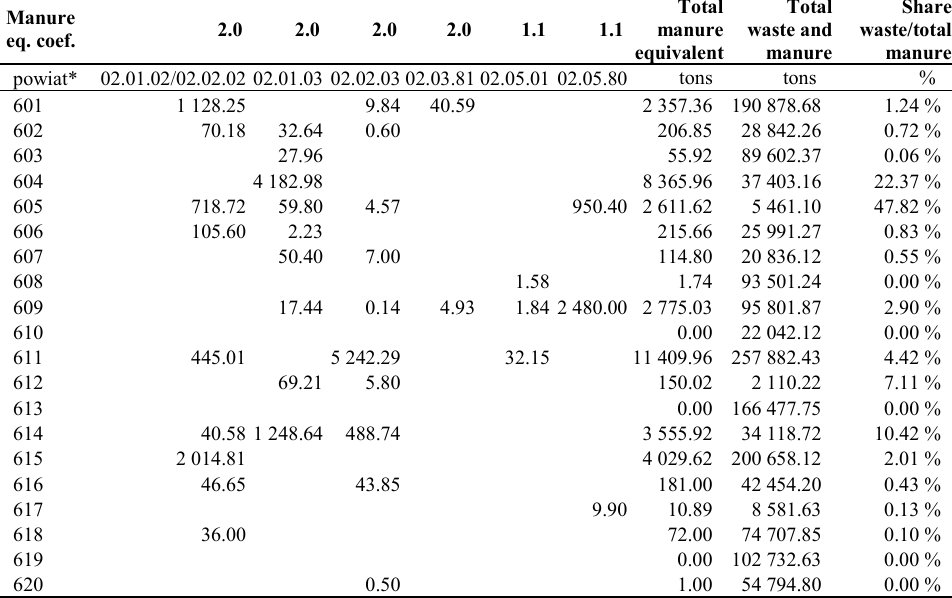
conversion technical coefficients (Table 1, heading, left side ) in order to extrapolate the manure equivalent (Table 1, heading, right side ) necessary to feed the identified biogas plants